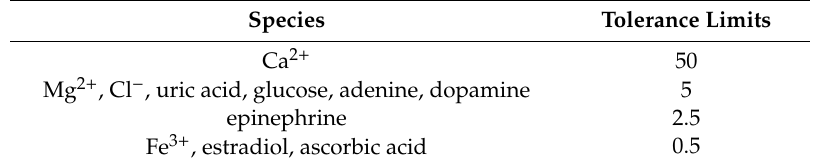
Table 1. Results of interference studies for the determination of 5.0 × 10 − 7 mol L − 1 EIMTC at the SPCE /